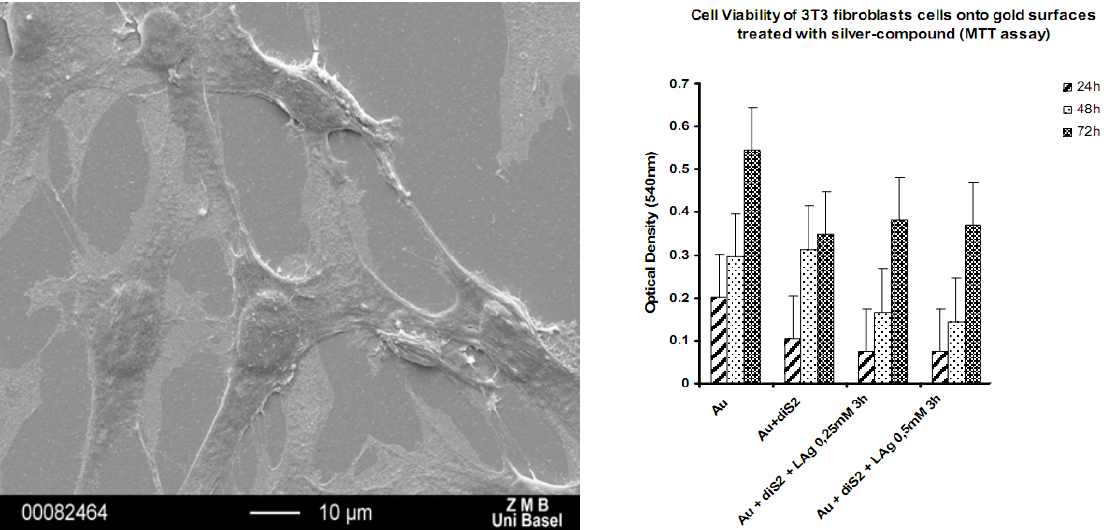
Figure 21. SEM of mouse fibroblasts adhering to a with 1 coated Au(111) substrate (left); cell viability of mouse fibroblast cells as a function of substrate coating